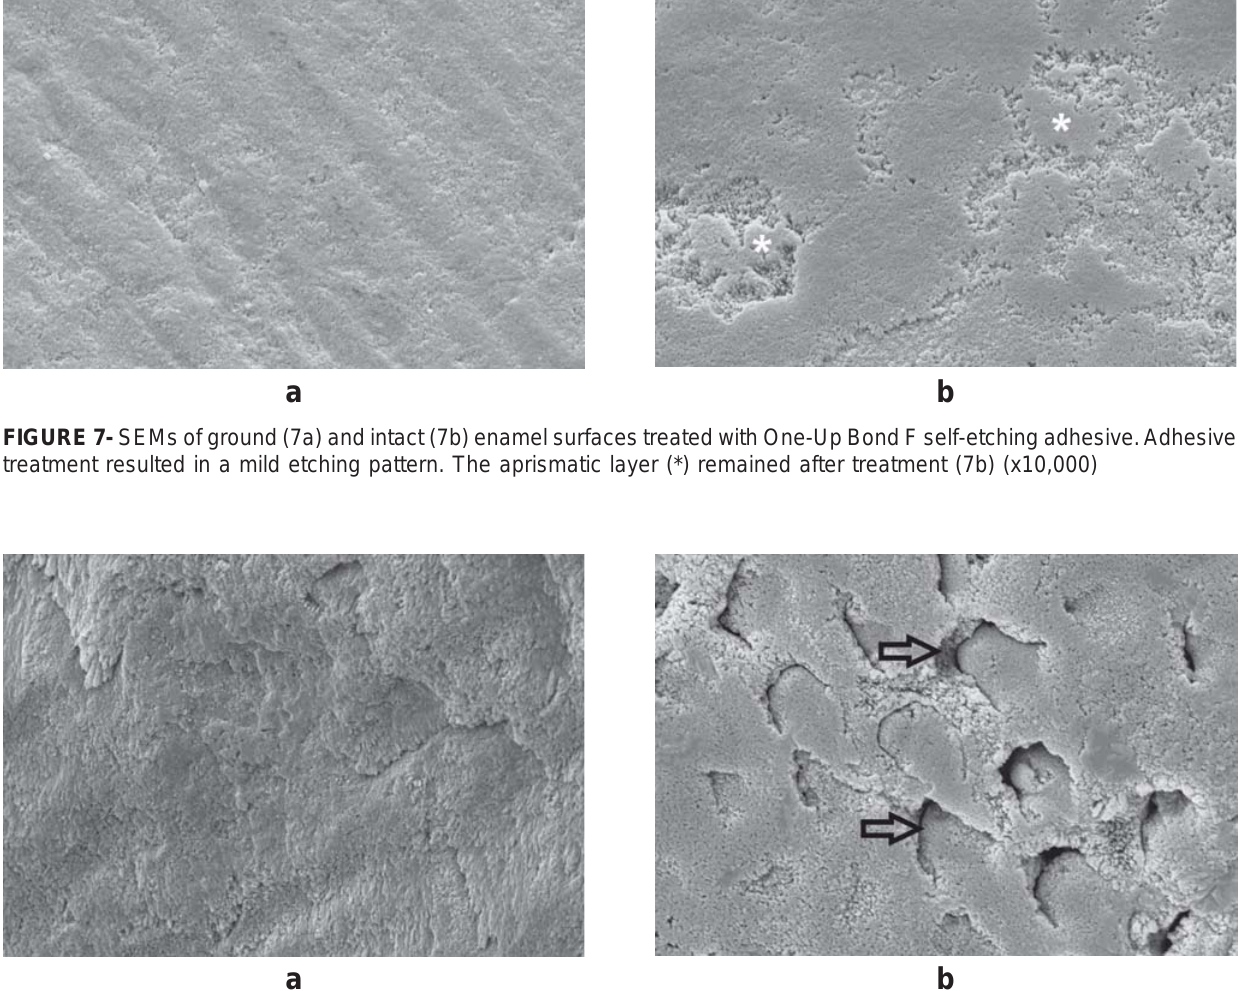
FIGURE 8- SEMs of ground (8a) and intact (8b) enamel surfaces treated with Optibond Bond Solo Plus self-etching primer. Moderate etching pattern was obtained after adhesive treatment (8a). Some areas showed etching effects at enamel prisms (arrows) (8b) (x10,000)